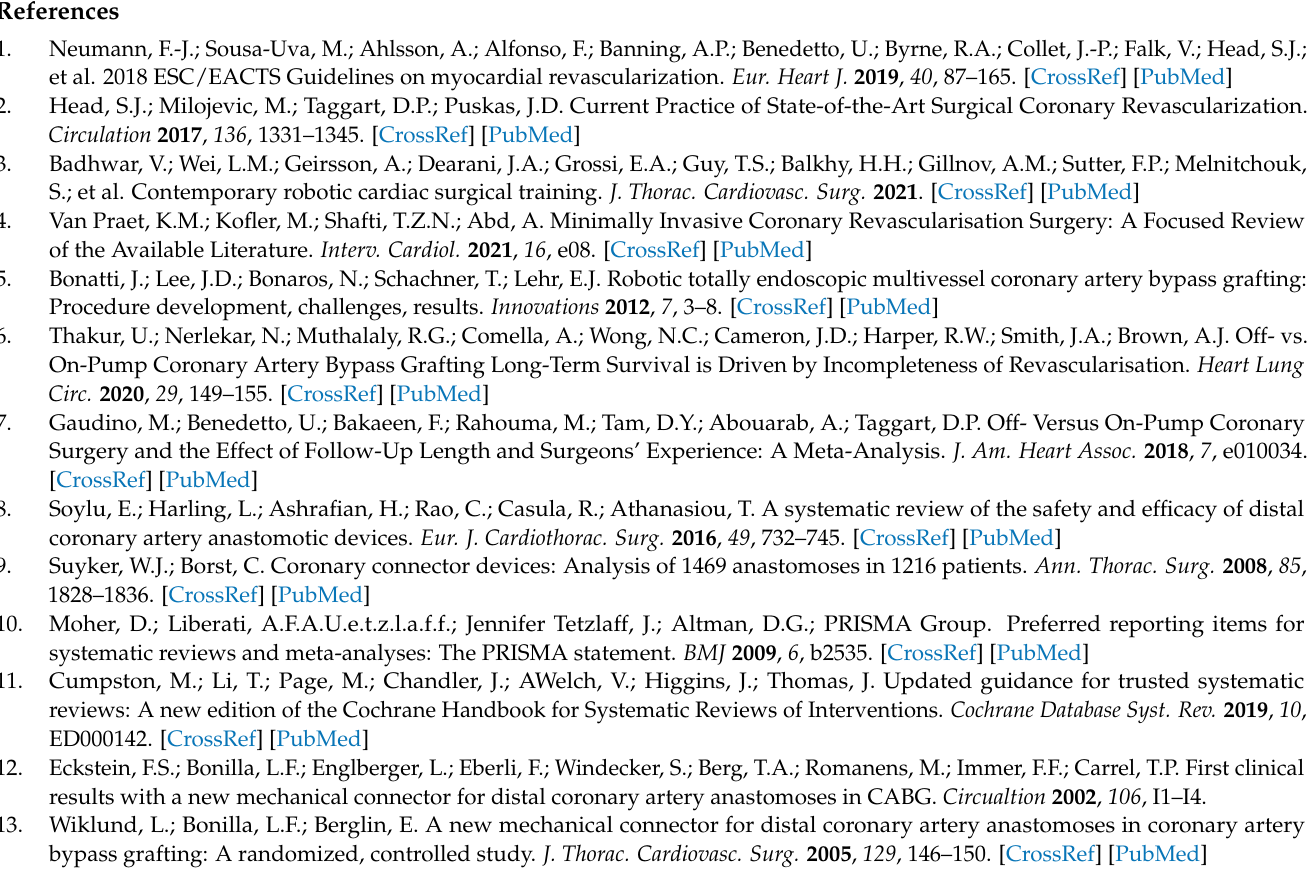
and exclusion criteria, Table S2: Newcastle-Ottawa quality assessment for cohort studies, Table S3: Study design, Table S4: Patient demographics, Table S5: Interventional details, Figure S1: Funnel